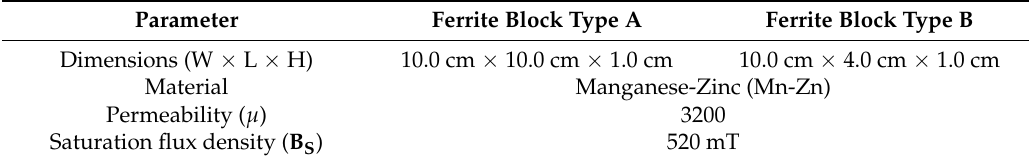
Table 3. Material characteristics of ferrite blocks types A and B identified in Figure 16.